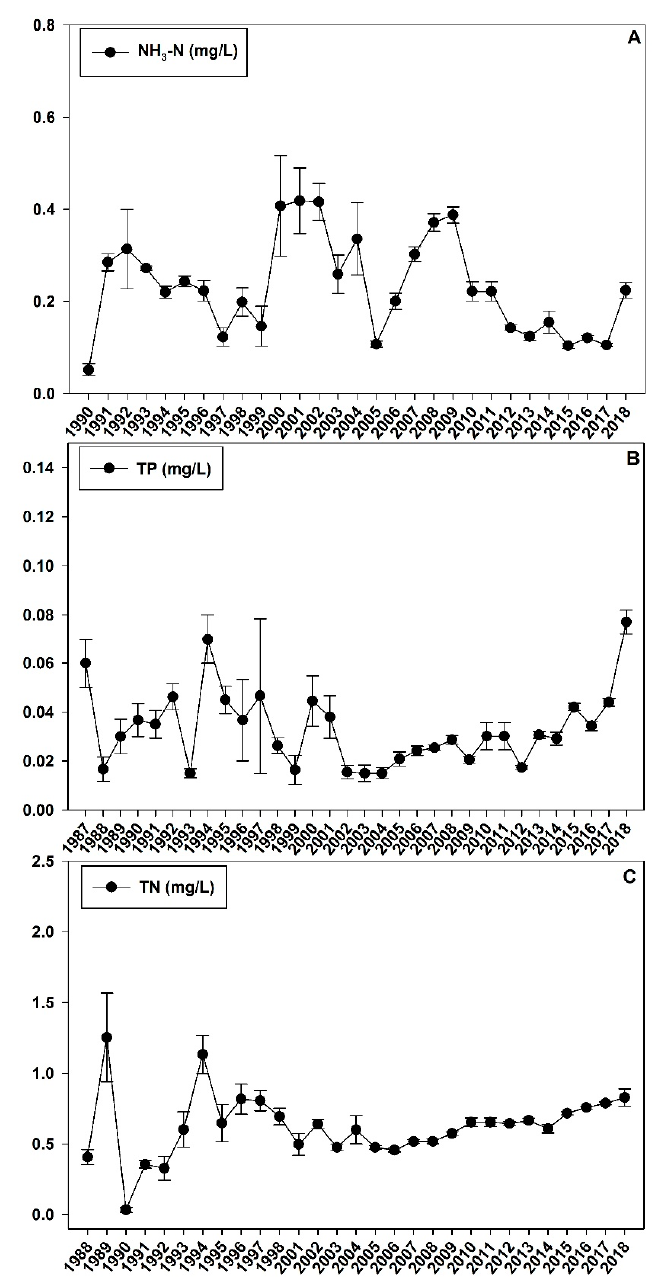
Figure 3. Historical water quality data ( A ): NH 3 -N; ( B ): TP; and ( C ): TN in Chenghai Lake from 1986 to